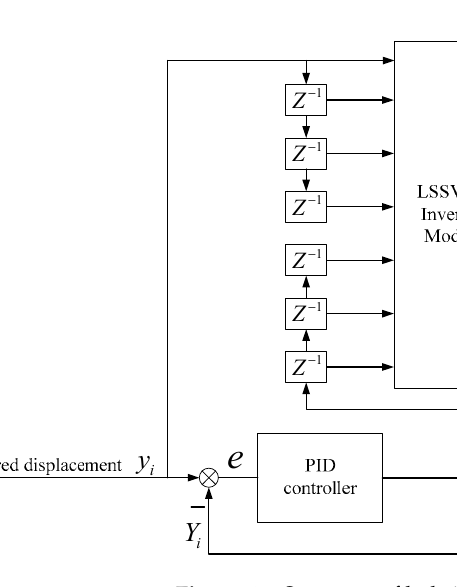
Figure 42. Structure of hybrid PID feedback controller. Figure 43. Structure of hybrid PID feedback